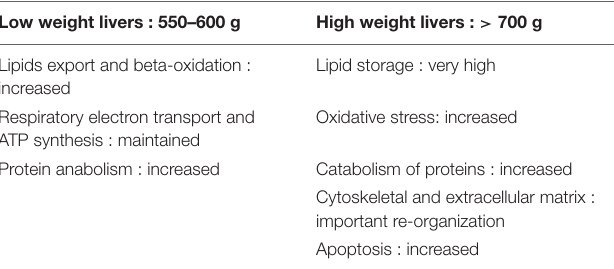
TABLE 2 | Summary of main cellular characteristics differing between high and low weight